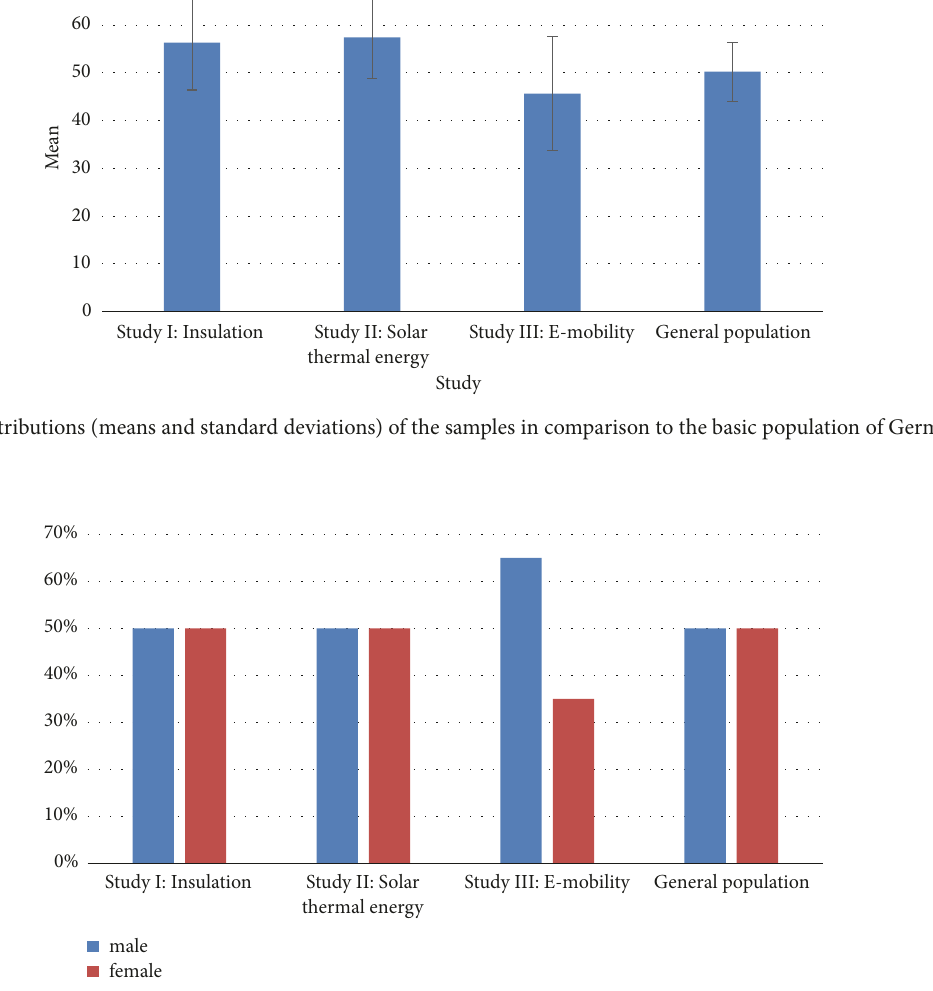
Figure 2: Gender distributions (in percent) of the samples in comparison to the basic population of German adults.